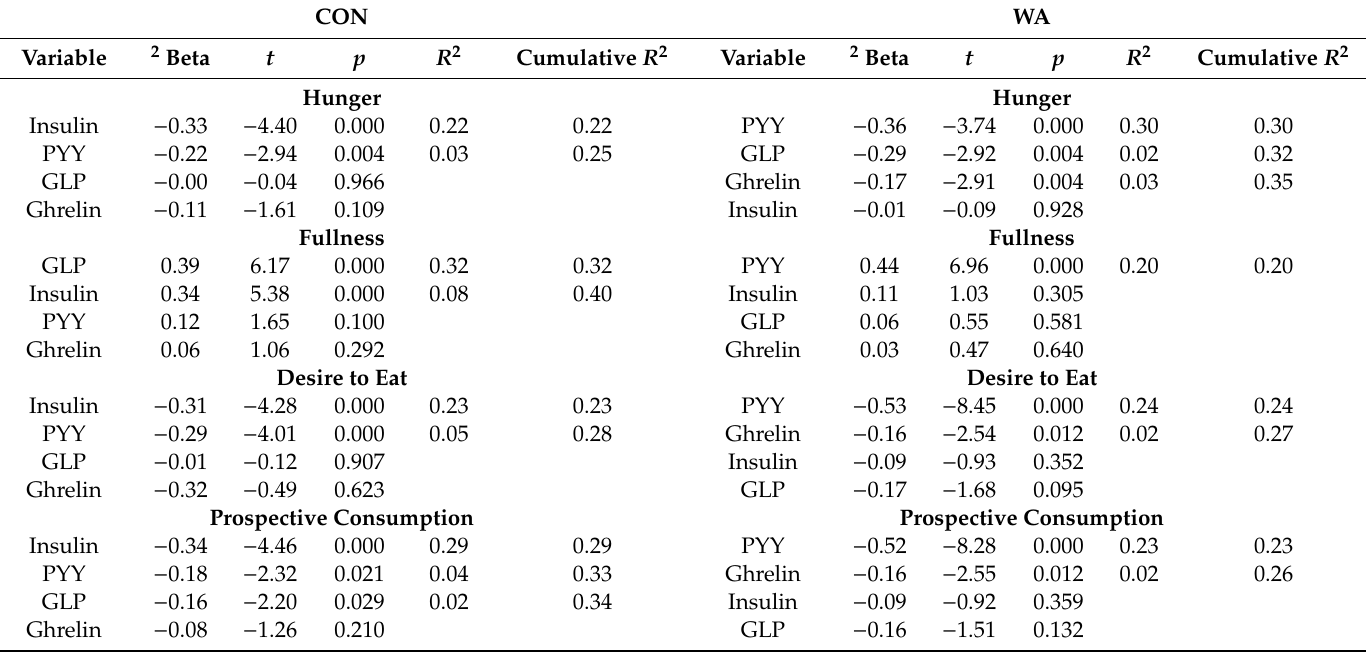
Table 4. Association between subjective satiety ratings and satiety hormones in overweight / obese participants 1